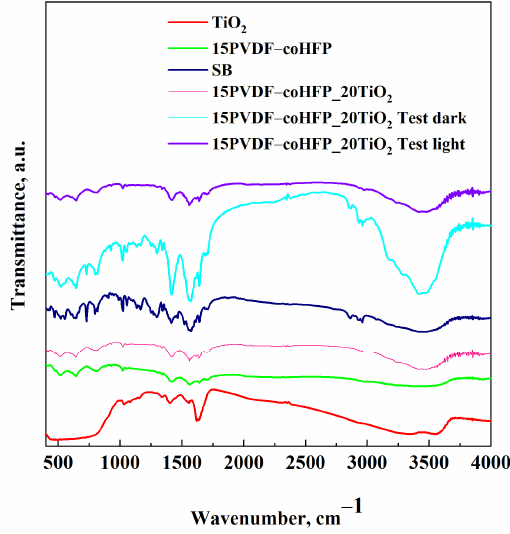
Figure 11. FT-IR spectra of TiO 2 (red line), PVDF-coHFP (green line), SB (blue line), 15PVDF-coHFP_20TiO 2 (pink line), 15PVDF-coHFP_20TiO 2 after cycle V in dark conditions (cyan curve) and 15PVDF-coHFP_20TiO 2 after cycle V under UV-light exposure (violet curve). FT-IR spectrum of PVDF-coHFP showed bands at 2900 cm − 1 (C-H stretching), 1049 cm − 1 (CH 2 wagging), 1336 cm − 1 (antisymmetric -CF 2 stretch), 1020 cm − 1 (-CF 3 out-of-plane deformation), 927 and 644 cm − 1 (related to α -phase), 813 cm − 1 (related to β -phase) and at 873